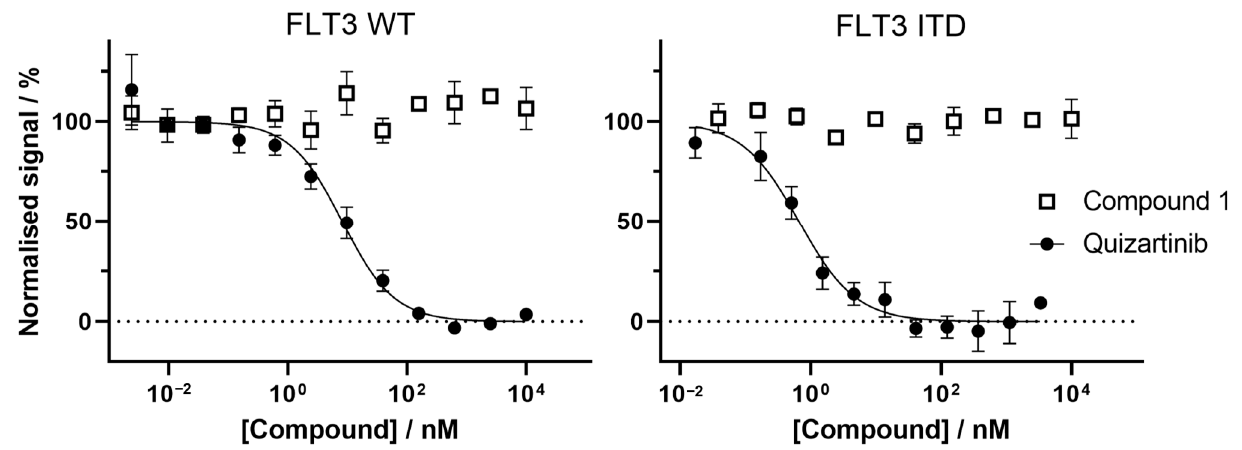
Figure 6. Measurement of binding between 1 and FLT3 variants. Compound 1 (squares) does not bind to either FLT3 WT or FLT-ITD mutant active site at the concentrations tested (up to 10 µM). The emission ratio (normalized signal) remains constant despite increasing compound concentra- tion. As a comparison, quizartinib (solid circles) behave as expected, with IC 50 of 8.2 nM against FLT3 WT and 0.7 nM against FLT3-ITD mutant, calculated from fitting the normalized signal with an inhibitory dose response curve (see methods). Error bars represent the standard deviation ( n = 3). The X -axis is the Log 10 of the compound concentrations in nanomolar (nM), and the Y -axis shows the normalized emission ratio signal.